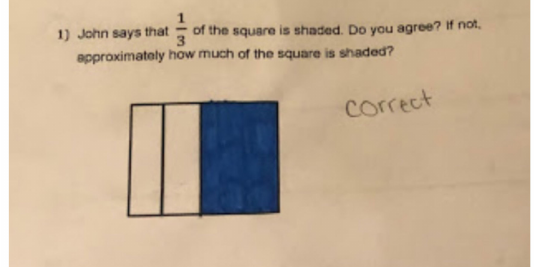
Figure 1. Representing 1/3.